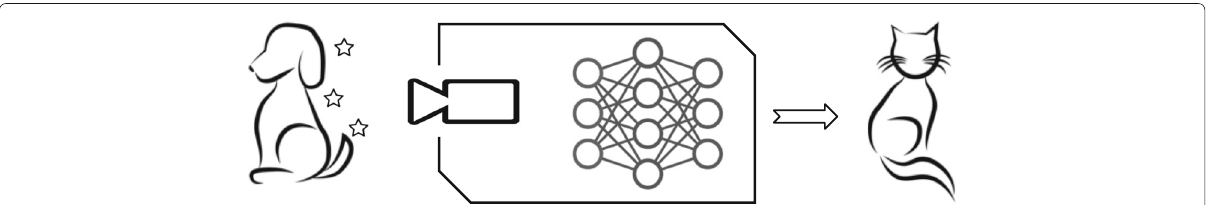
Fig. 3 Threat model for practical adversarial example